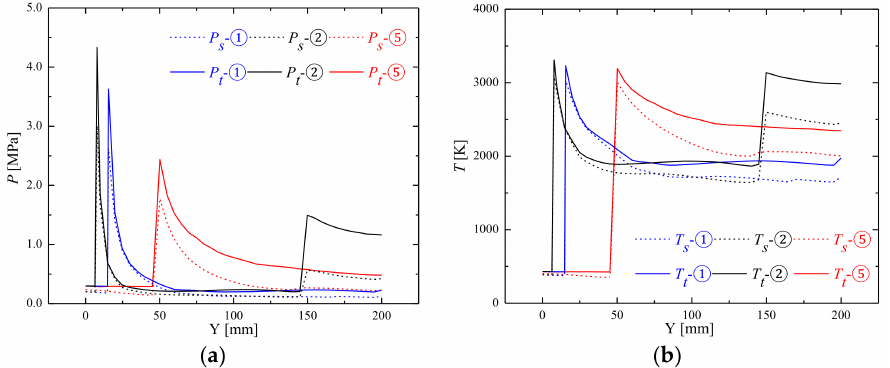
Figure 11. Variations of ( a ) pressure and ( b ) temperature along the three typical streamlines.